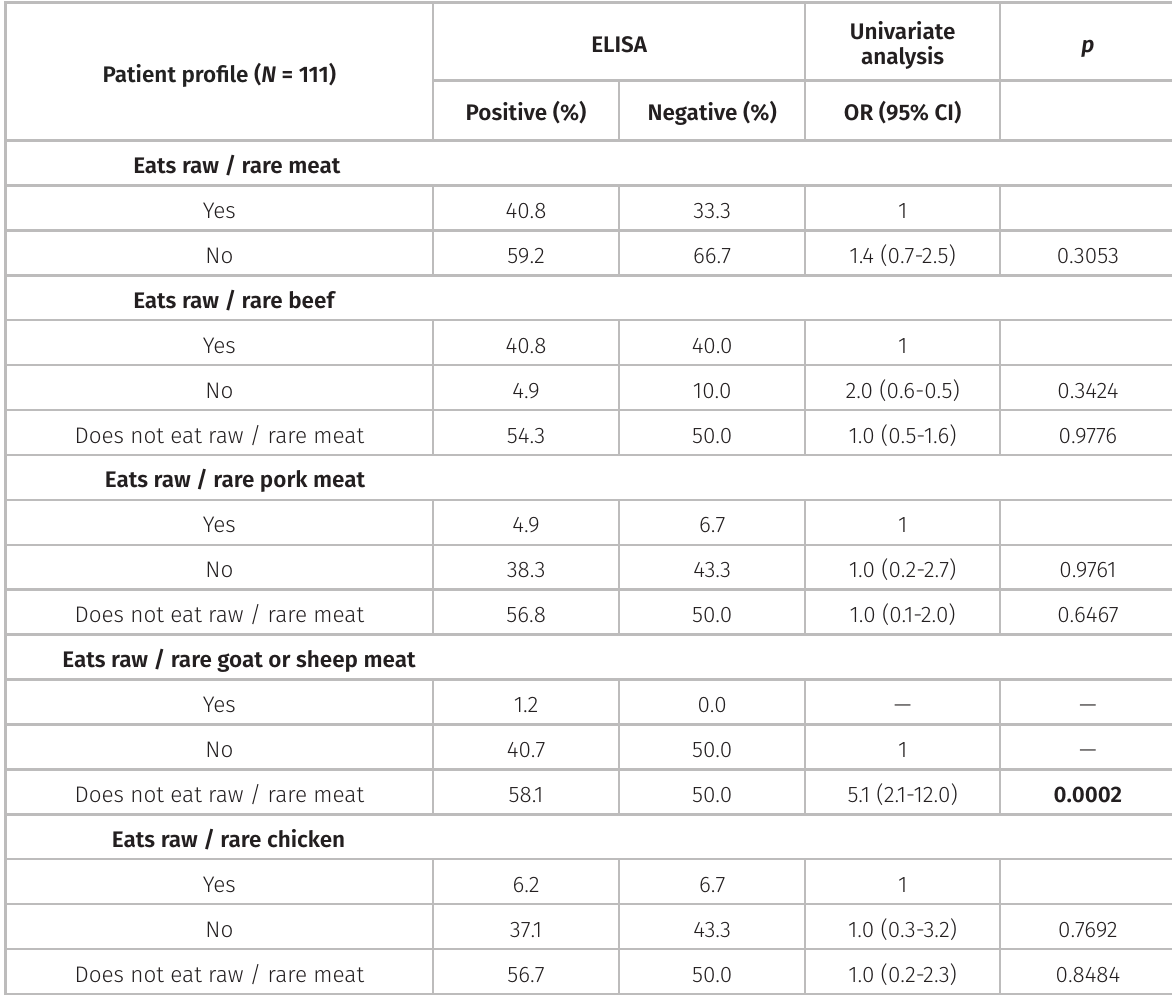
Univariate ELISA analysis